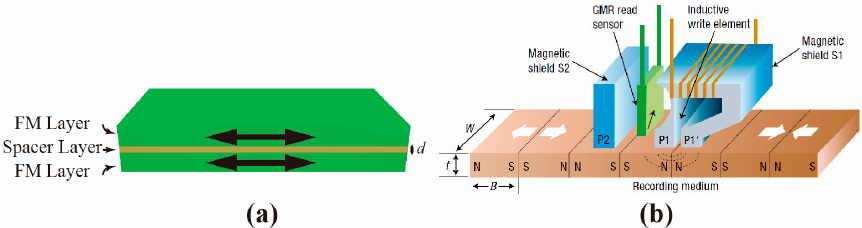
Figure 1. ( a ) Schematic of a GMR device with a FM layer/spacer layer/FM layer stacking. The thickness of the spacer layer is labeled as d; ( b ) GMR read-head for hard drive [2]. Reproduced with permission from [2].